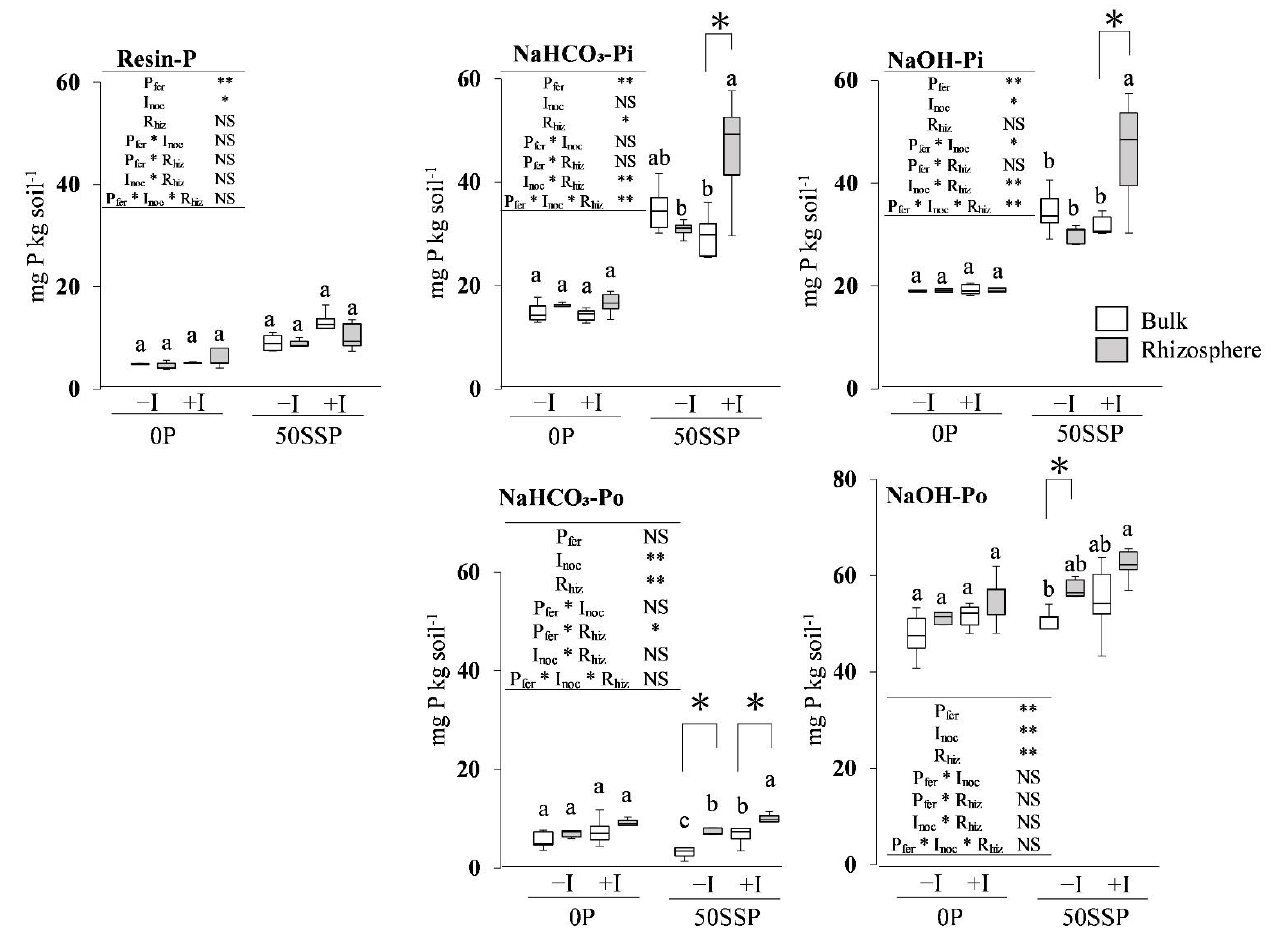
Figure 2. The amount of P fractionated by the modified Hedley’s methods. − I/+I and 0P/50SSP indicate Rhizobium inoculation and P fertilization. Bars indicate the standard error ( n = 5). Lowercase letters indicate the significant difference between the treatments, according to Tukey’s posthoc test ( p < 0.05). * represents significant differences between the − I and +I treatments under 0P and 50SSP treatments according to Student’s t -test ( p < 0.05). NS, *, and ** in inserted tables indicate not significant, p < 0.05 and p < 0.01, respectively, estimated using three-way ANOVA. P fer , I noc , and R hiz indi-